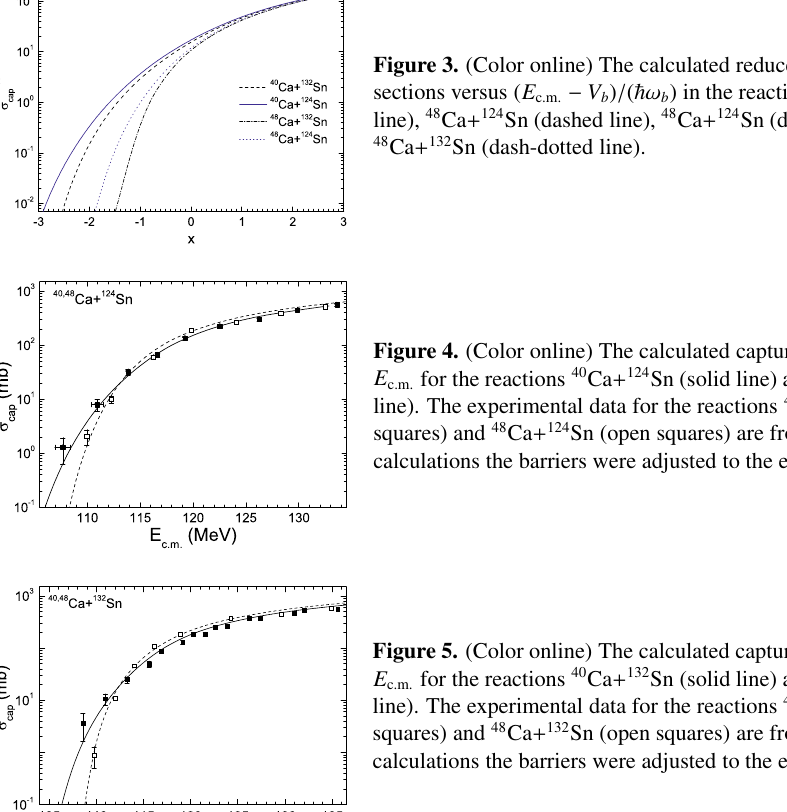
Figure 5. (Color online) The calculated capture cross sections versus E c . m . for the reactions 40 Ca + 132 Sn (solid line) and 48 Ca + 132 Sn (dashed line). The experimental data for the reactions 40 Ca + 132 Sn (solid squares) and 48 Ca + 132 Sn (open squares) are from Ref. [16]. In the calculations the barriers were adjusted to the experimental